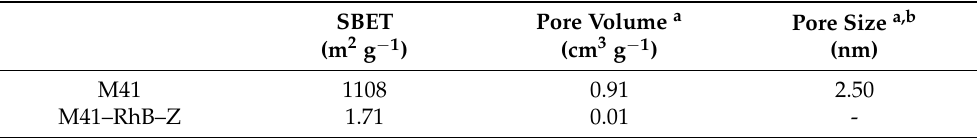
Figure 2. ( a ) Nitrogen adsorption ( ⚪ )–desorption ( ● ) isotherms of the calcined M41 solid and the final M41–RhB–Z solid at standard temperature and pressure conditions (STP); ( b ) pore distribution graph for M41 and ( c ) pore distribution graph for M41–RhB–Z. Table 1. BET specific surface values, pore volumes and pore sizes calculated from the N 2 adsorption–desorption isotherms for selected materials.